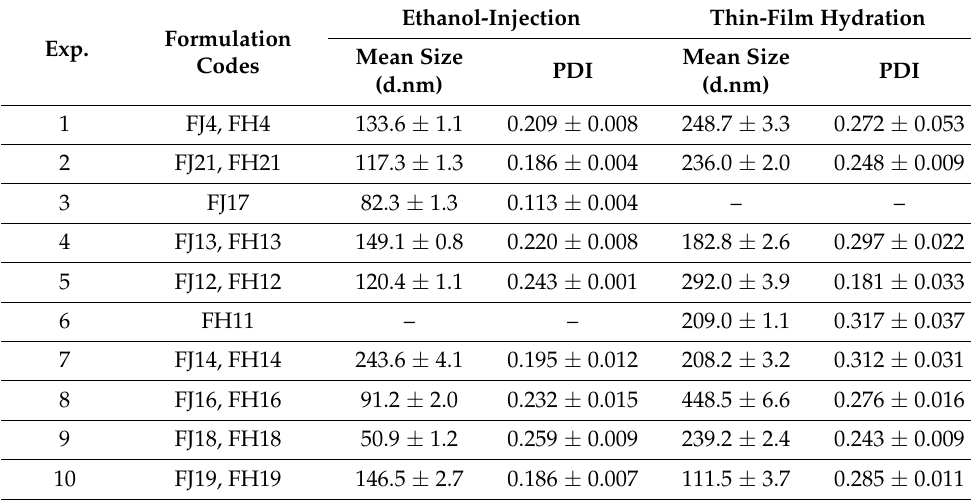
Table 1. Comparison of the size and polydispersity index (PDI) of berberine (BBR)-loaded liposomes fabricated by ethanol-injection (FJ) and thin-film hydration (FH) methods (after extruding 60 times through a polycarbonate membrane with a pore size of 0.4 µ m) and analyzed with the Zetasizer Nano ZSP system ( n = 3; mean ± SD).